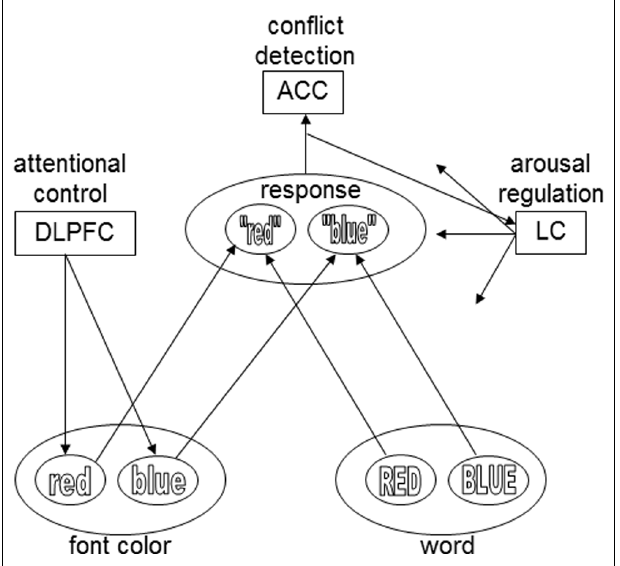
FIGURE 1 |The presentation of an incongruent Stroop stimulus (e.g., the word BLUE printed in red) causes conflict, which is detected by a conflict-monitoring system (ACC). The ACC activates the LC, which releases norepinephrine throughout the cortex. Norepinephrine strengthens Hebbian learning for active representations. During subsequent presentations of the specific stimulus type, conflict is reduced and reaction time is shorter.The DLPFC influences the input layers, based on task demands: in this example, font color is the relevant stimulus dimension, and the task demand unit therefore biases that input layer. For the sake of simplicity, only two colors and response options are plotted here.The arrows from the LC module in this model exemplify the widespread projections of the LC. However, in the model ofVerguts and Notebaert (2008, 2009) conflict-induced release of norepinephrine only modulates the connections between input and task demand units – an assumption that was modified in later work by these authors (e.g., Braem etal.,